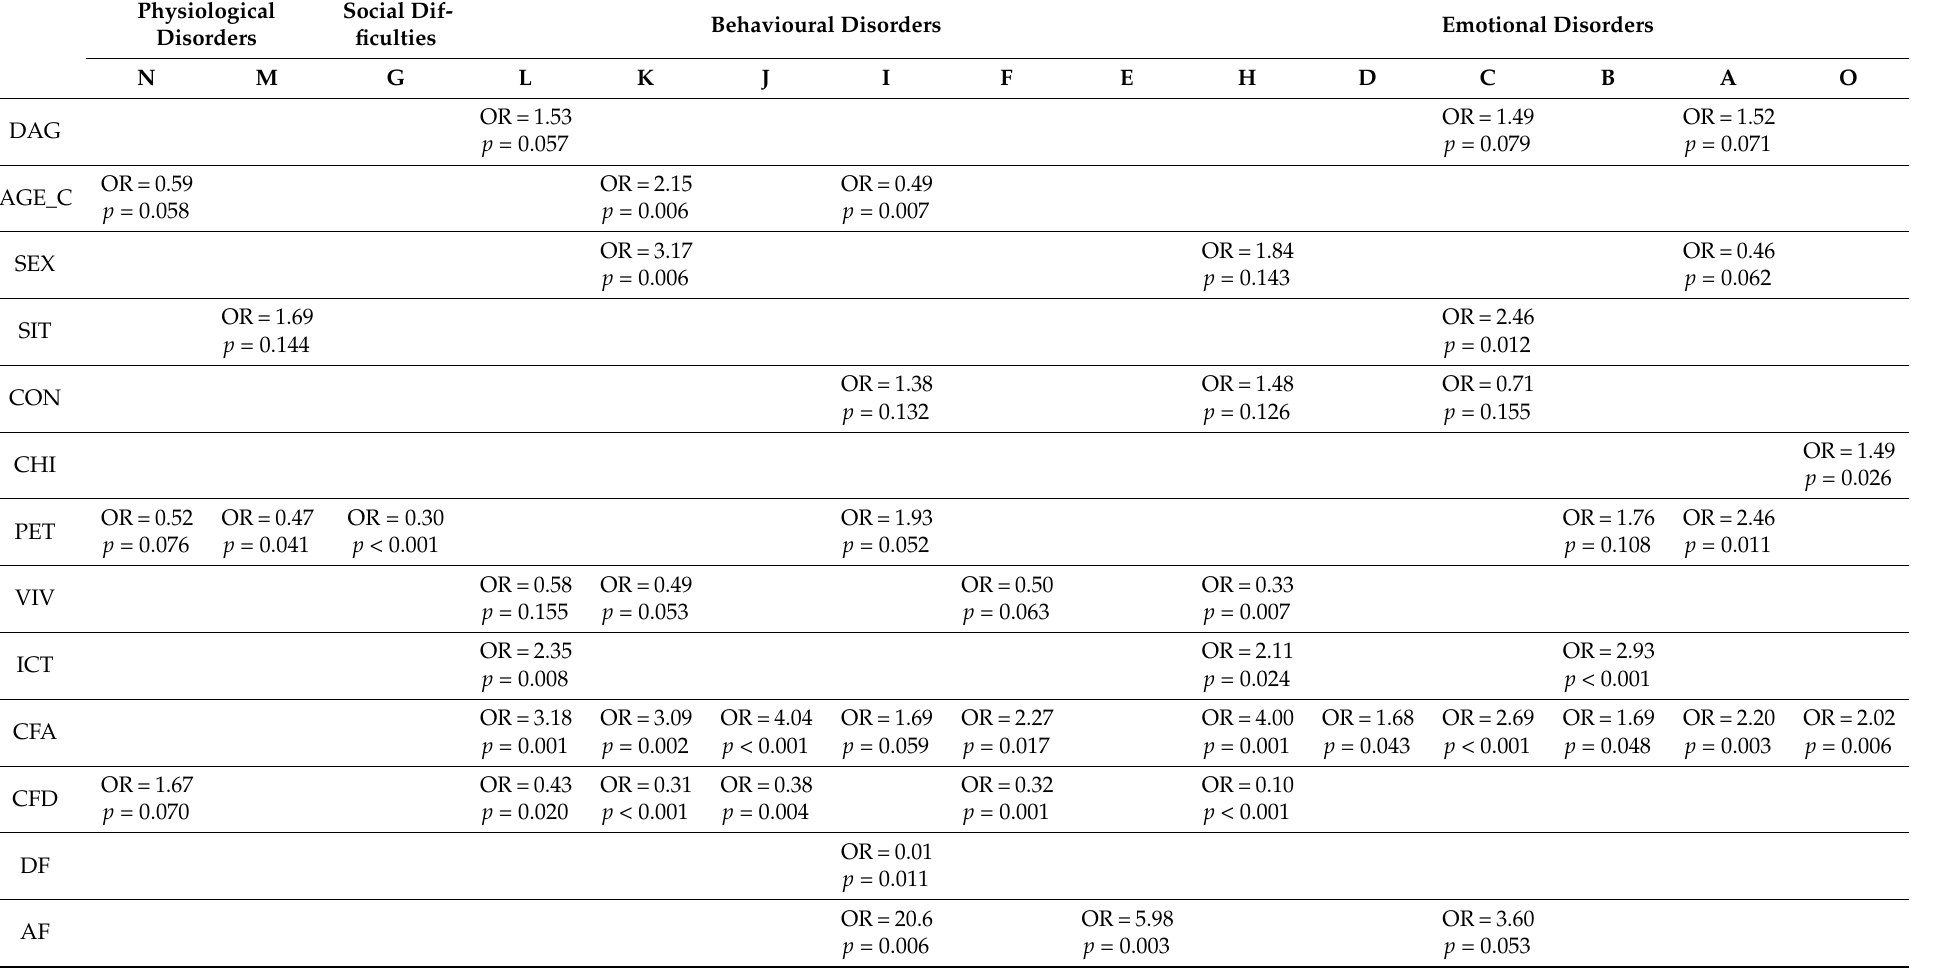
Table 3. Explanatory variables (OR and p -value). See Tables 1 and 2 with codification of the explanatory and response